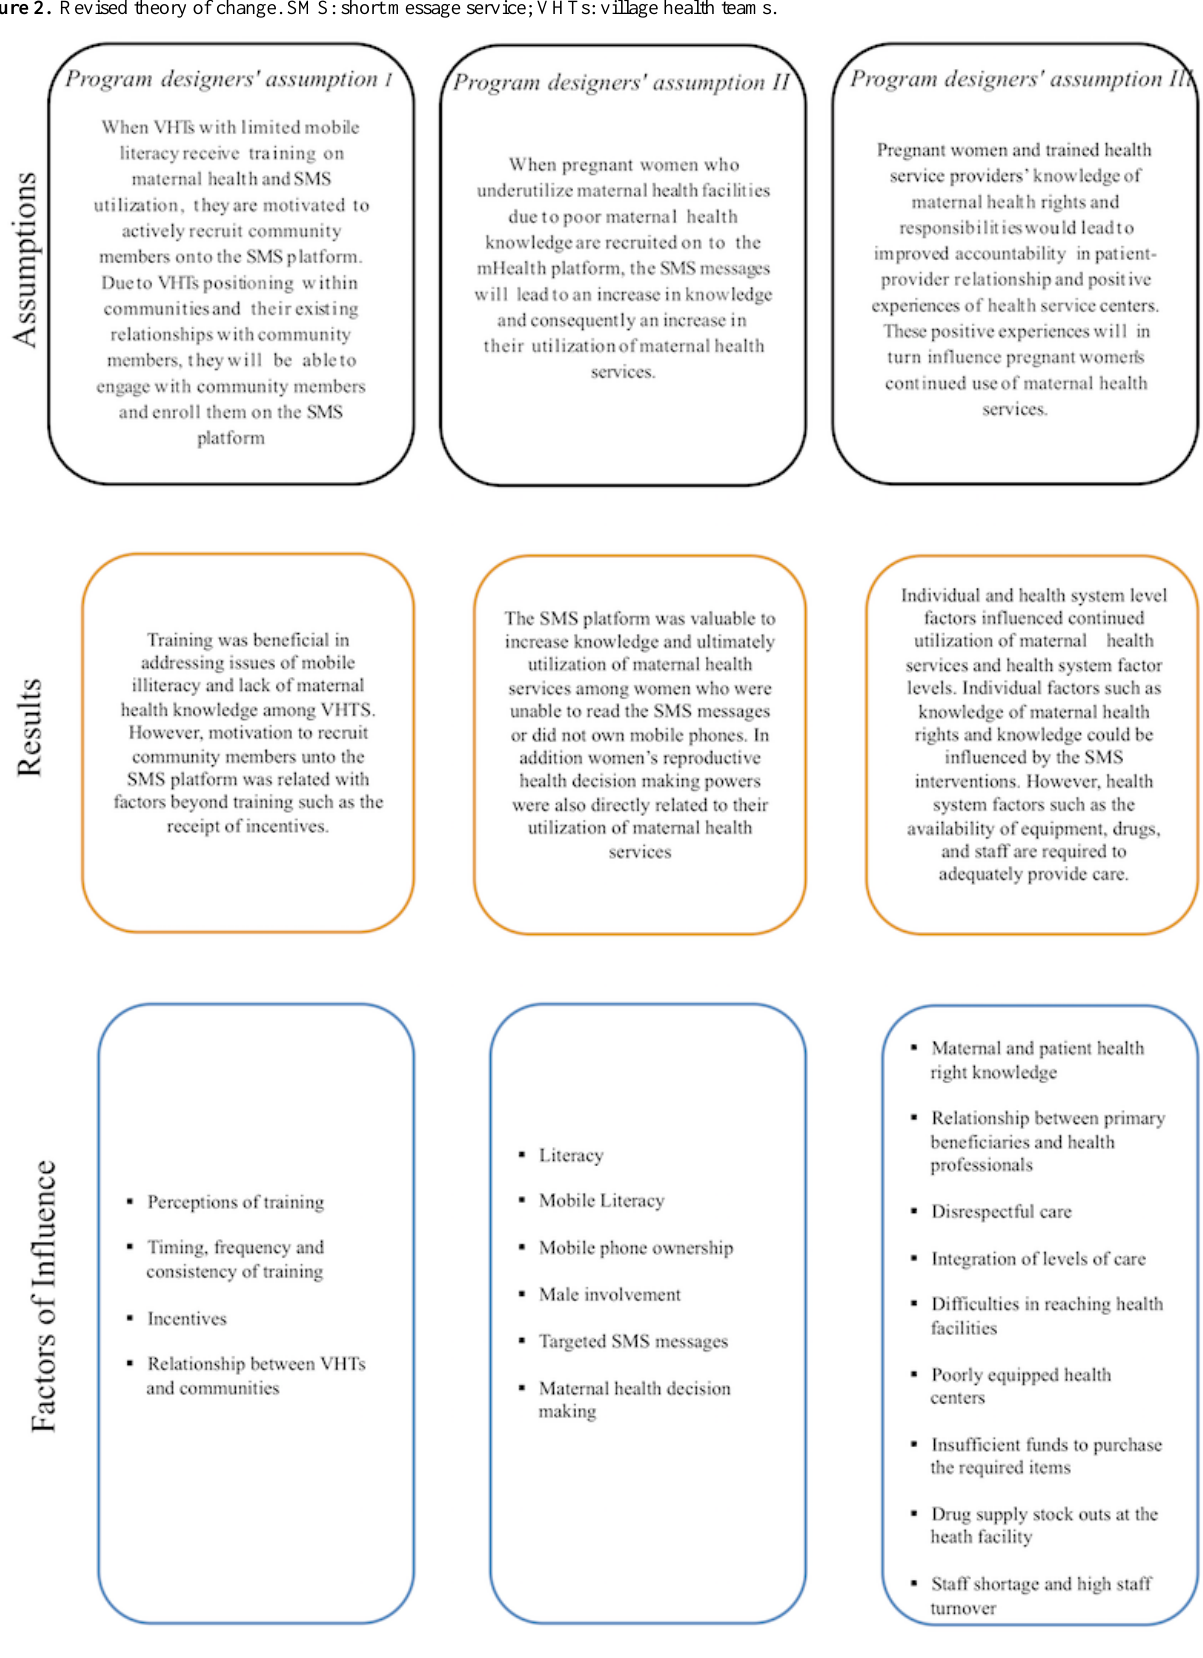
Figure 2. Revised theory of change. SMS: short message service; VHTs: village health